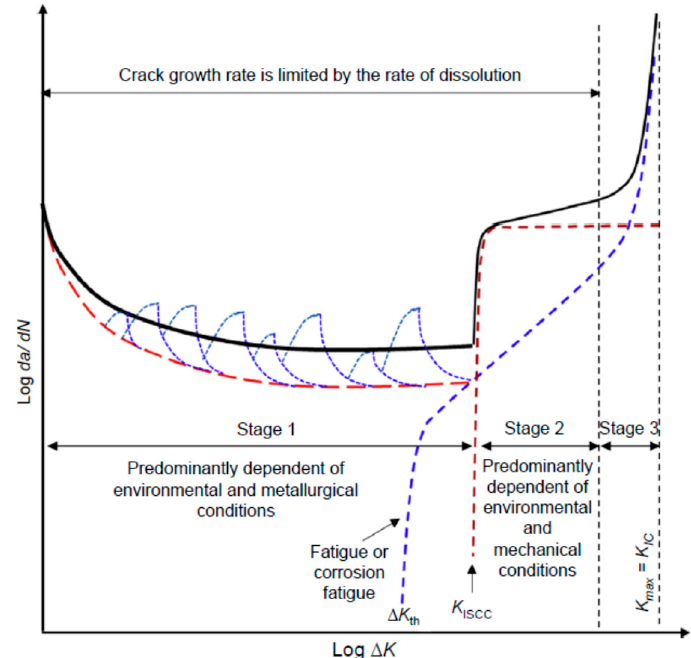
Figure 6. Effect of Δ K upon SCC velocity of pipeline steel exposed to carbonate, bicarbonate solution [28]. Reproduced with permission from [28], Elsevier, 2017.